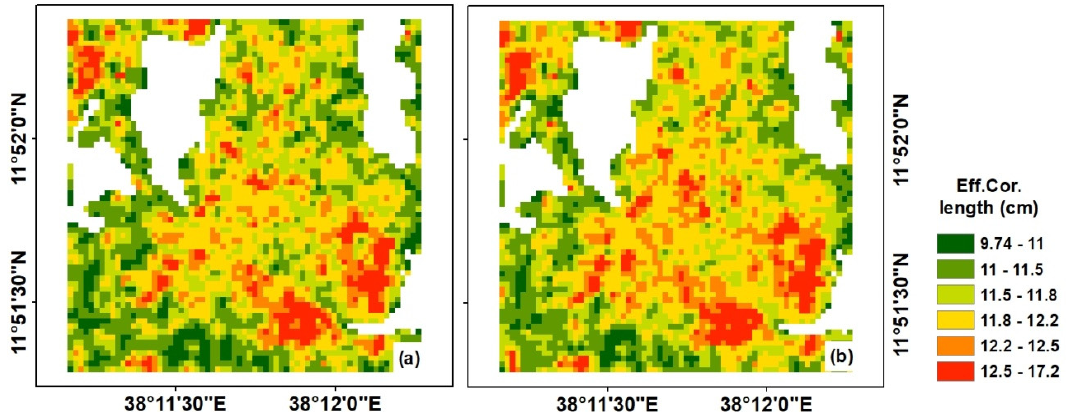
Figure 8. E ff ective correlation length ( l ef f ) of the surface: ( a ) based on the average h rms and ( b ) based Figure 8. Effective correlation length ( 𝑙 (cid:3032)(cid:3033)(cid:3033) ) of the surface: ( a ) based on the average ℎ (cid:3045)(cid:3040)(cid:3046) and ( b ) on February h rms based on February ℎ (cid:3045)(cid:3040)(cid:3046) values.